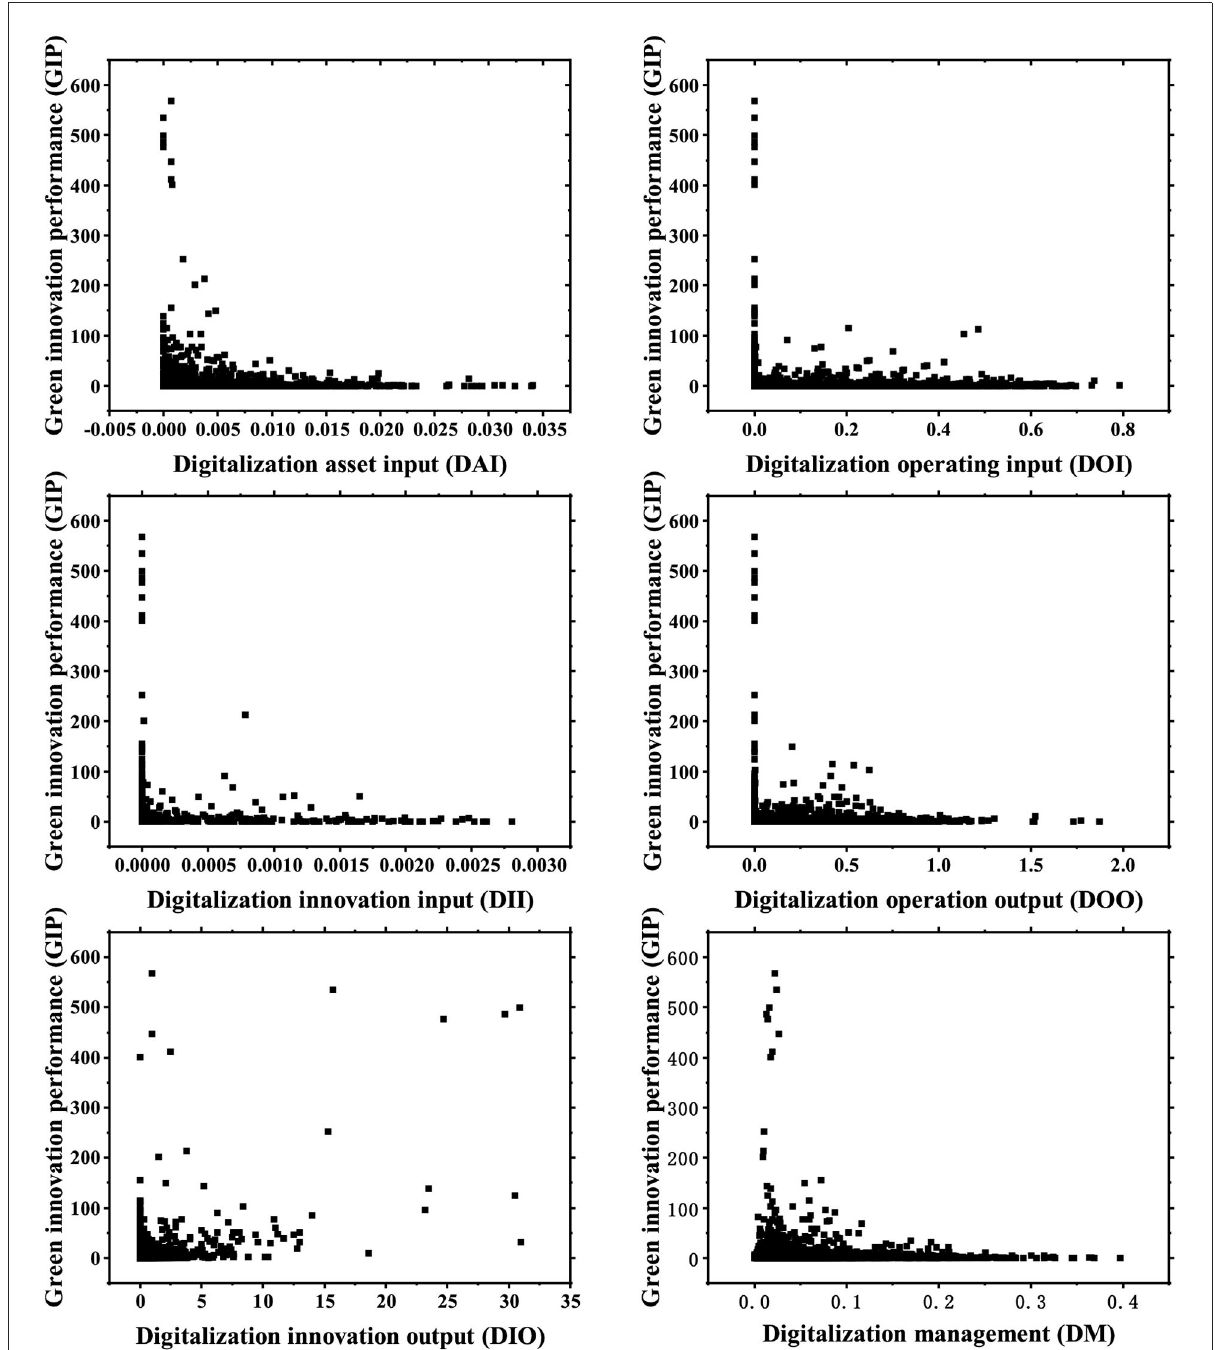
FIGURE5 Scatterplot of the relationship between digitalization features and green innovation